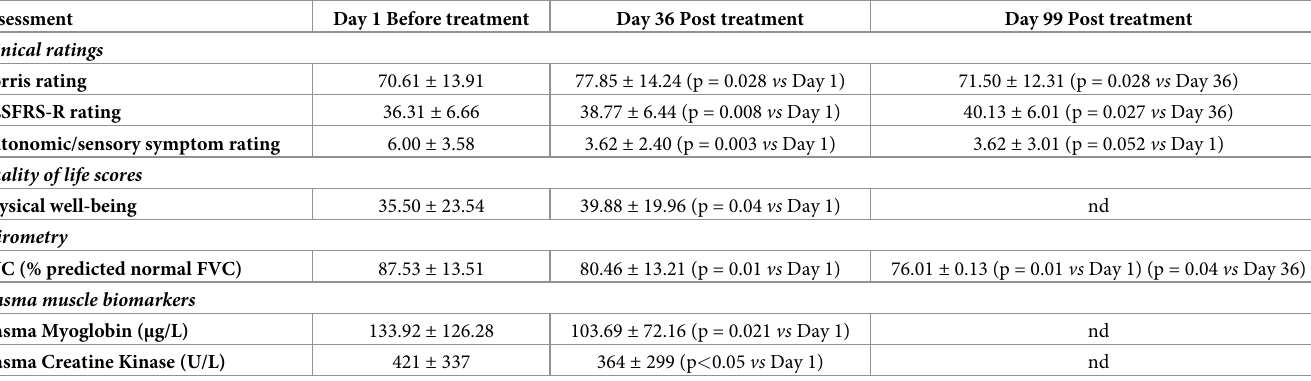
There was a 10% decrease in FVC from study entry at Day 1 to Day 36 (p < 0.02, paired T-test), but no further significant change in FVC was observed during the 49 days between Visit 8 (Day 50) and Visit 9 (Day 99). The average weekly decrease in spirometry score during Days 1–36 was -3.36% per week, but this rate of decline was arrested by Day 36 and maintained at -0.49% per week over Days 36–99 (Table 9). Table 9. Clinical and laboratory measurements of patients with ALS (N = 13; Mean ± SD; ns = not significant; nd = not determined; � = evidence of subgroup